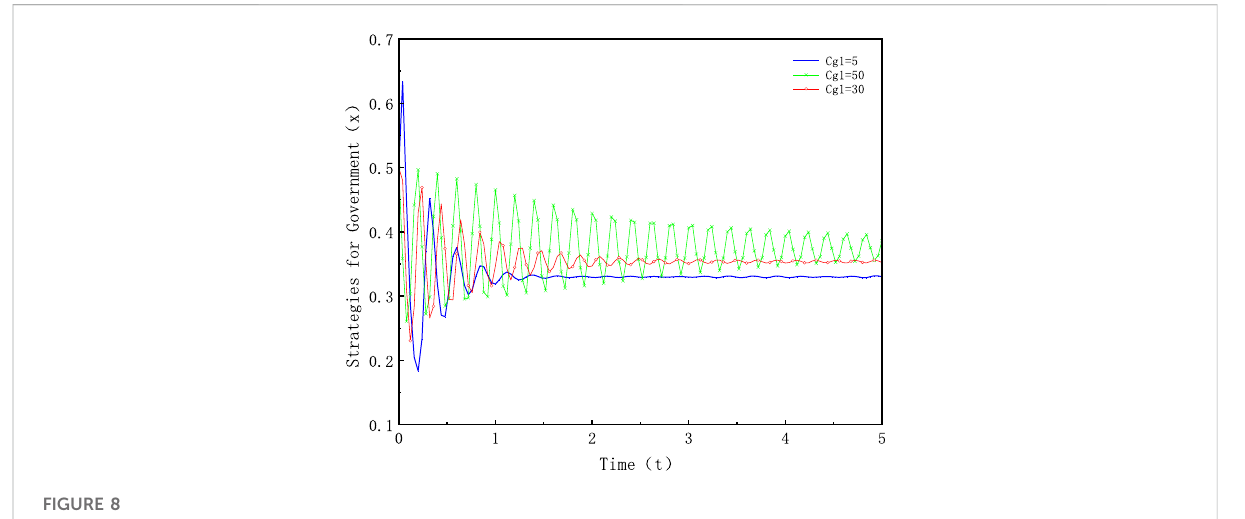
FIGURE 8 Strategies evolution of government under different